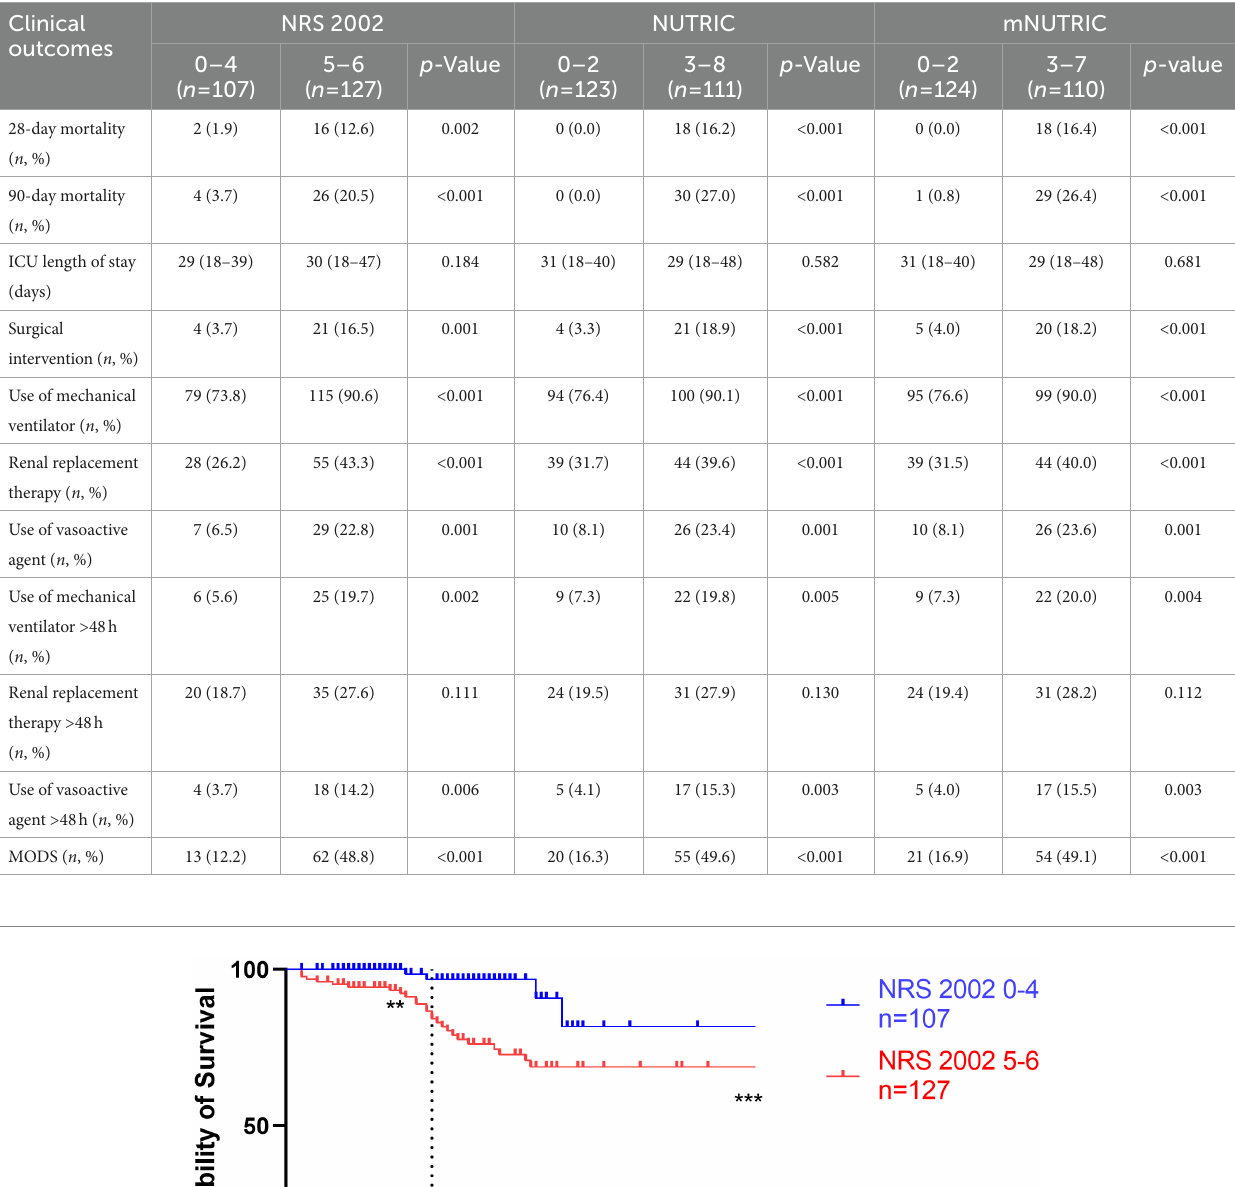
TABLE 3 Comparison of clinical outcomes in SAP patients categorized as high nutritional risk and low risk by the NRS2002, NUTRIC, and mNUTRIC.